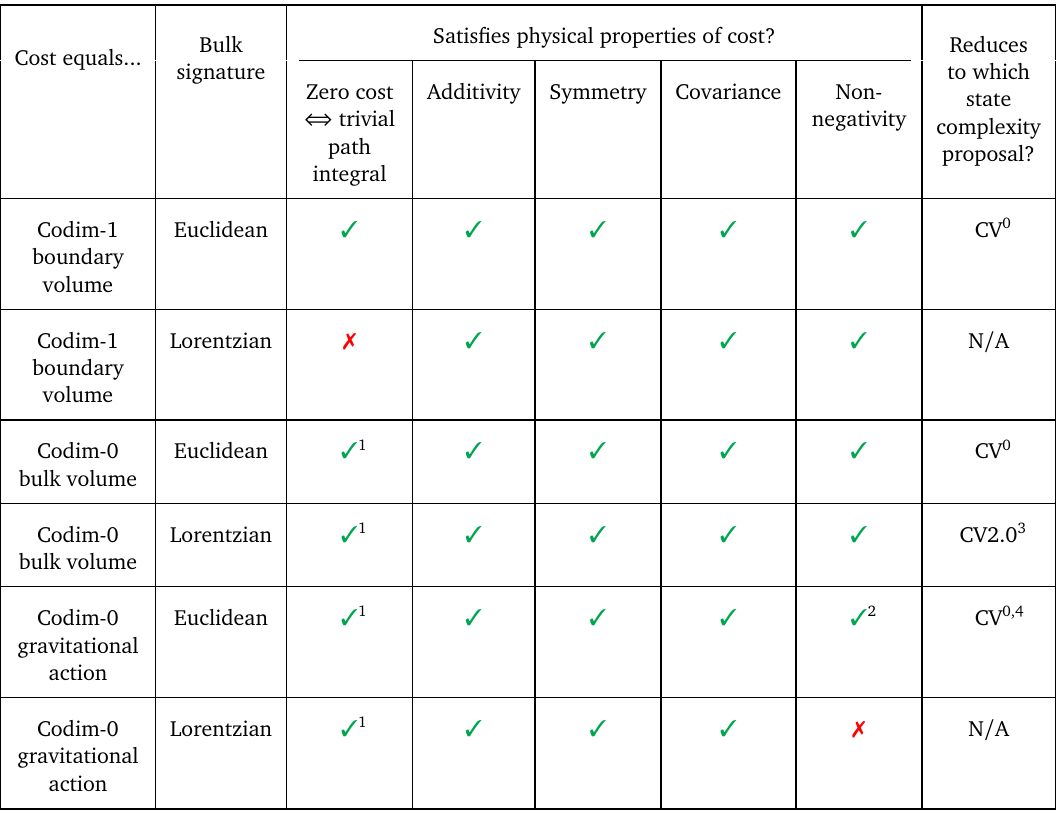
Table 1: Summary of the subset of path integral cost proposals that are considered in detail in this paper. Includes the metric signature of the bulk to which the proposal applies to, which of the physical properties of cost that are satisfied, and, when all properties are satisfied, which holographic state complexity proposal the cost pro- posal reduces to. Satisfies physical properties of cost? Reduces proposal?Zero cost Additivity Symmetry Covariance Non- ⇔ trivial path integral